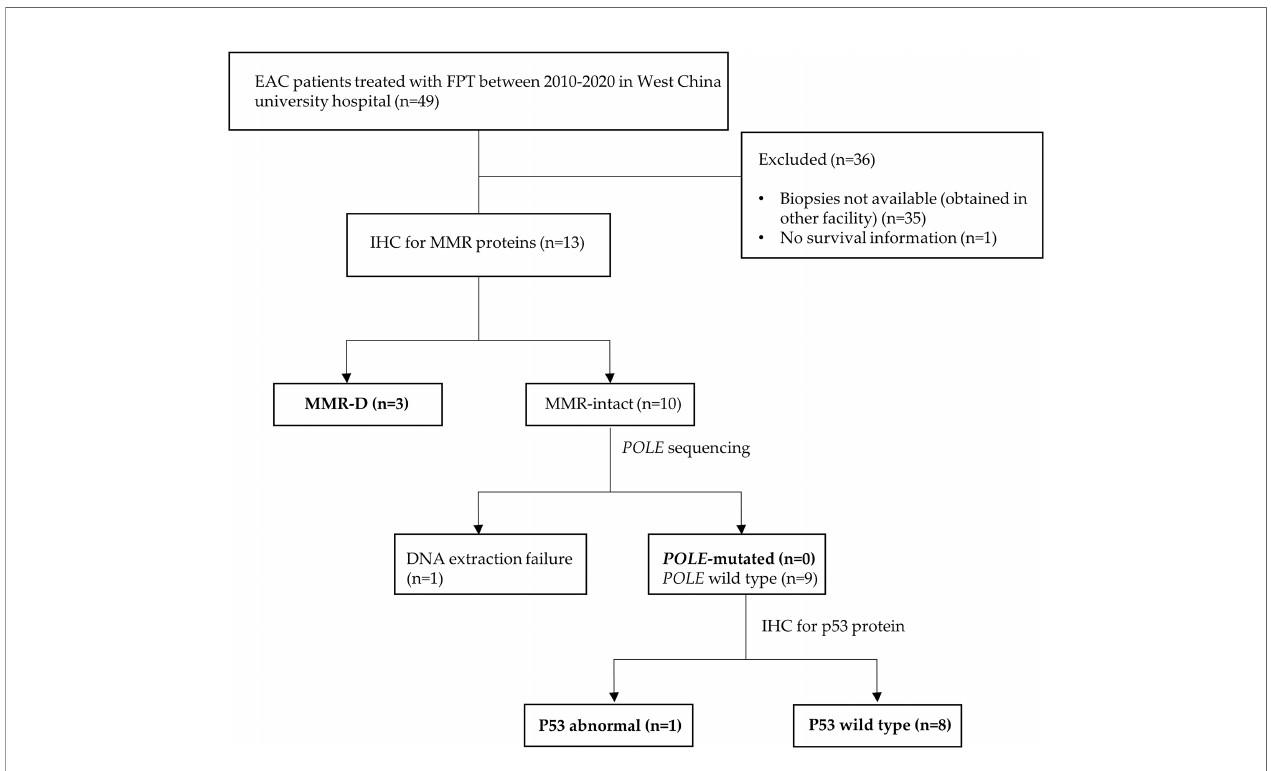
FIGURE 1 | Flow chart of patient selection and ProMise algorithm apllication.